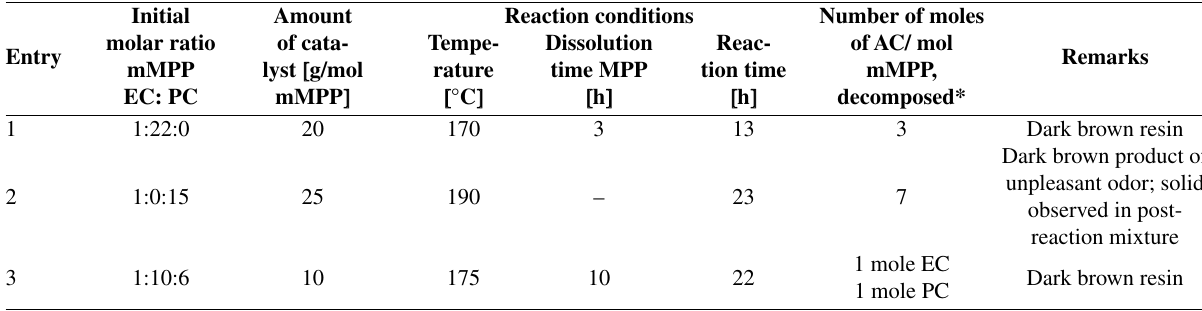
Table 1. Synthesis conditions of oligoetherols from MPP and alkylene carbonates